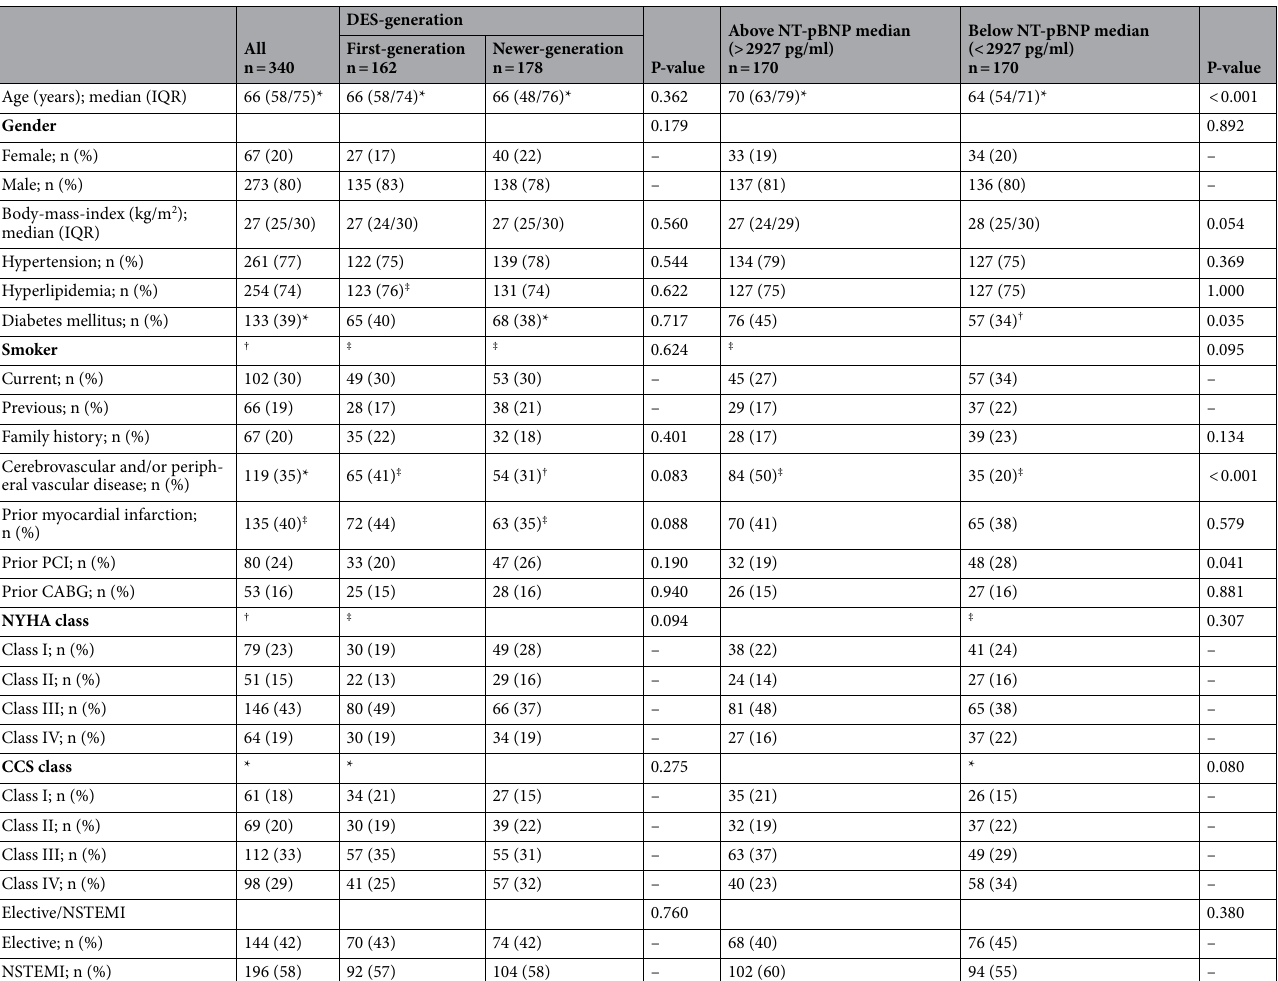
Table 1. Demographics, comorbidities and clinical presentation of all patients, subgroups according to DES- generation and subgroups with above and below NT-pBNP median (2927 pg/ml, IQR 1282/8524).